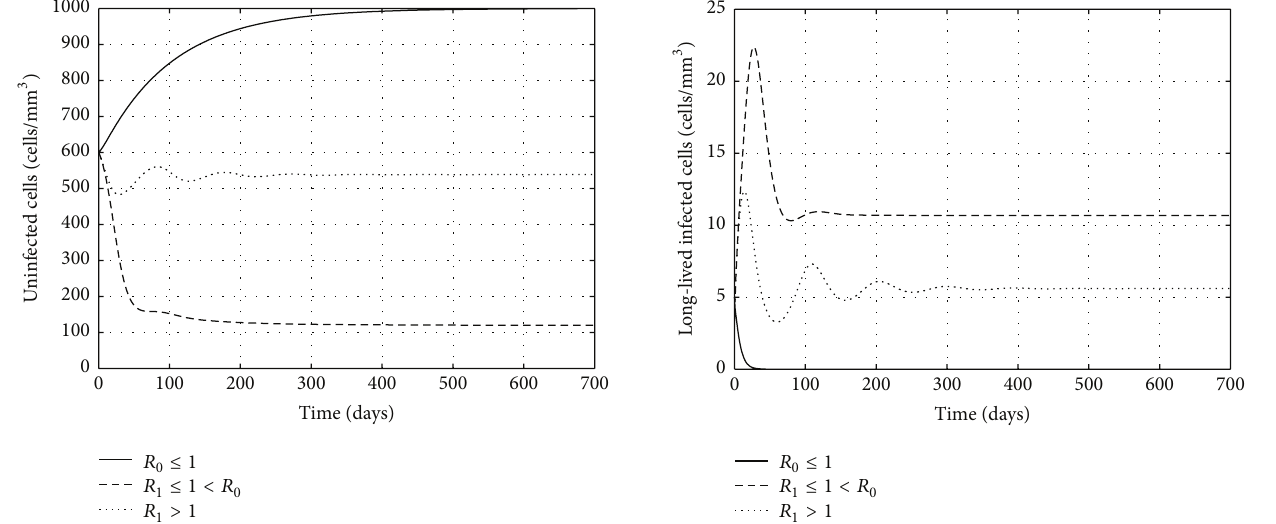
Figure 3: The concentration of long-lived chronically infected cells for model (104).